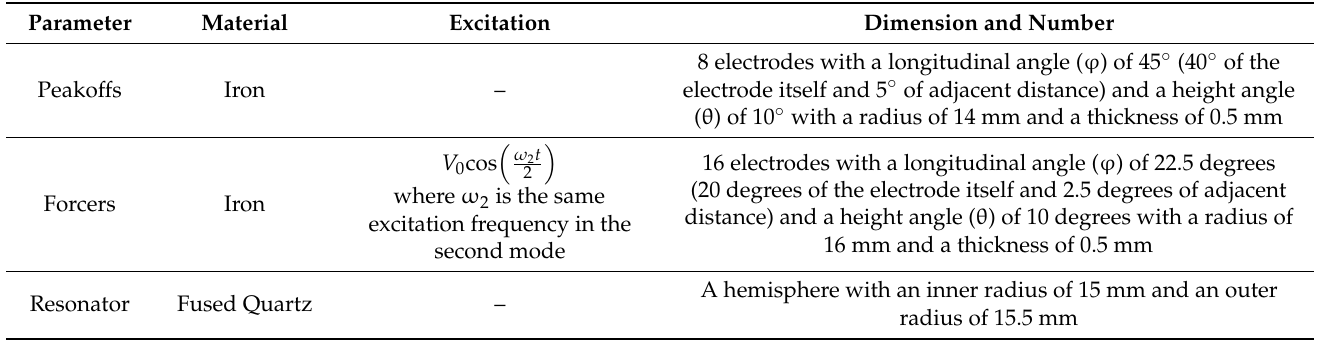
Table 4. Material of electrodes, type of driving force and their dimensions.